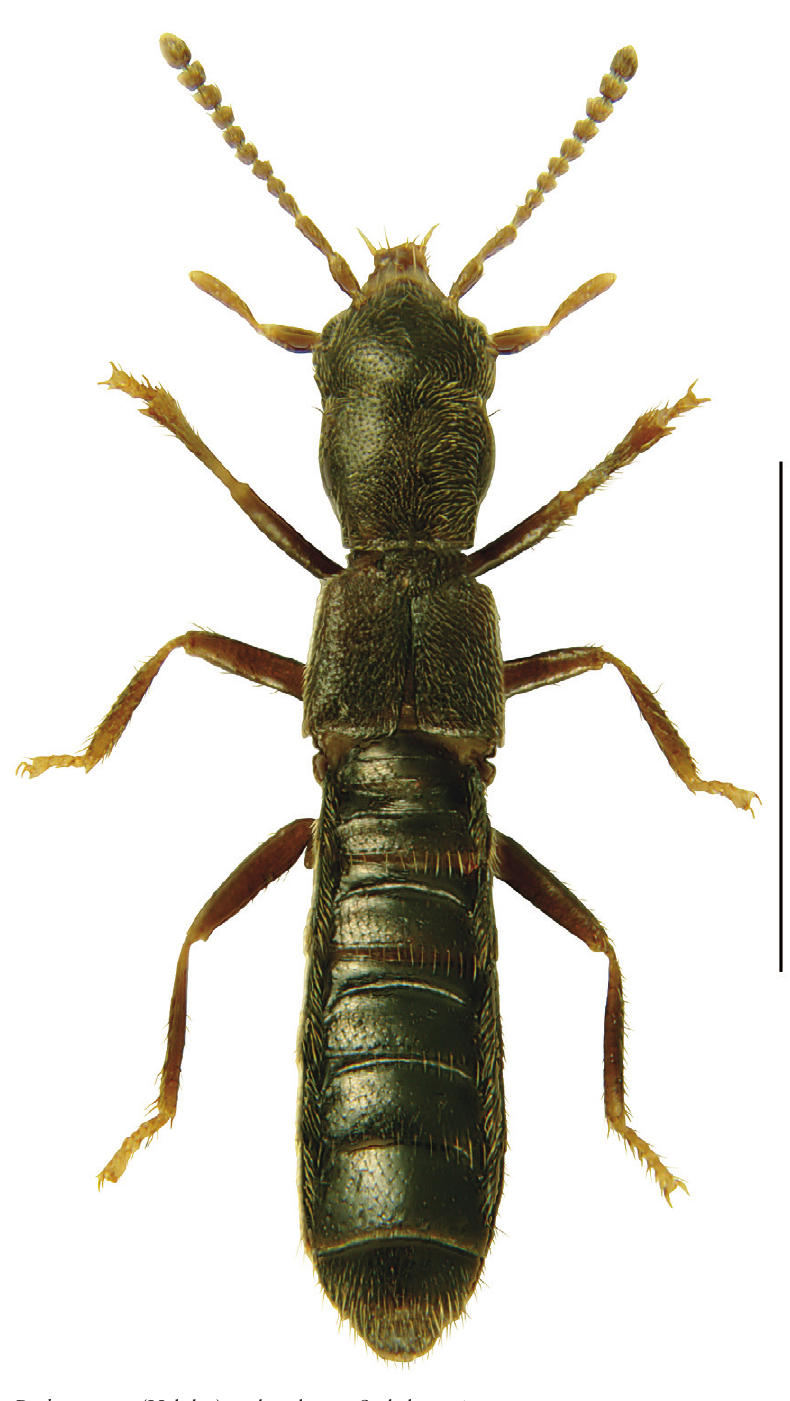
Fig. 1. Diglotta mersa (Haliday) in dorsal view. Scale bar = 1